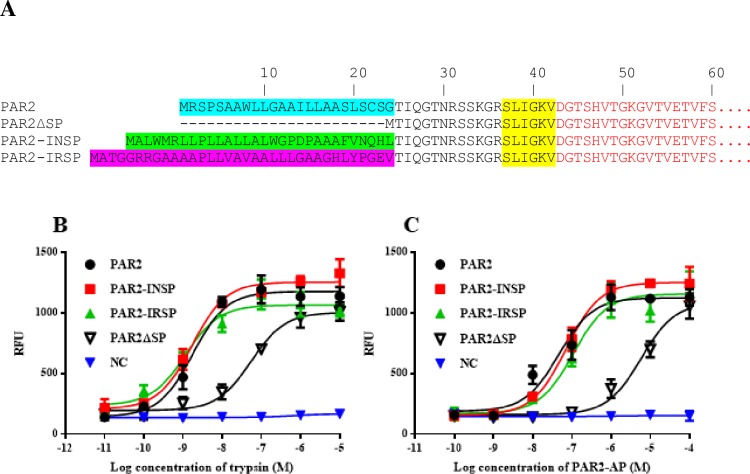
A signal peptide is important for functional expression of PAR2.A. schematic diagram showing the modifications to PAR2 receptor. The N-terminal extracellular sequences of various PAR2 mutants are shown. Human PAR2 wild type (PAR2), PAR2 with the signal peptide deleted (PAR2ΔSP), PAR2 with an insulin signal peptide (PAR2-INSP) and an insulin receptor signal peptide (PAR2-IRSP). The native signal peptide of PAR2 is shown in blue. The insulin and insulin signal peptides are shown in green and purple respectively. The tether ligand sequence of PAR2 (SLIGKV) is highlighted in yellow. B, C. Characterization of PAR2 mutants in FLIPR assay using trypsin or the synthetic PAR2 agonist peptide (PAR2-AP) as the ligands. Expression constructs for PAR2 wild type receptor and various modifications were cloned into pcDNA3.1 and transiently expressed in HEK293 cells with par1 and par2 knocked-out. Various concentrations of trypsin (B) or PAR-AP (C) were added to stimulate the intracellular Ca2+ mobilization. Relative fluorescent intensity units (RFU) are shown. The experiments were performed in triplicates at each data point and the results shown are mean ± sd. HEK293 cells with par1 and par2 genes knocked-out were used as the host cells for recombinant expression of various PAR2 receptors. Untransfected cells were used as the negative controls (NC). The experiments have been performed 3 times and very similar results have been observed. Example data is shown.